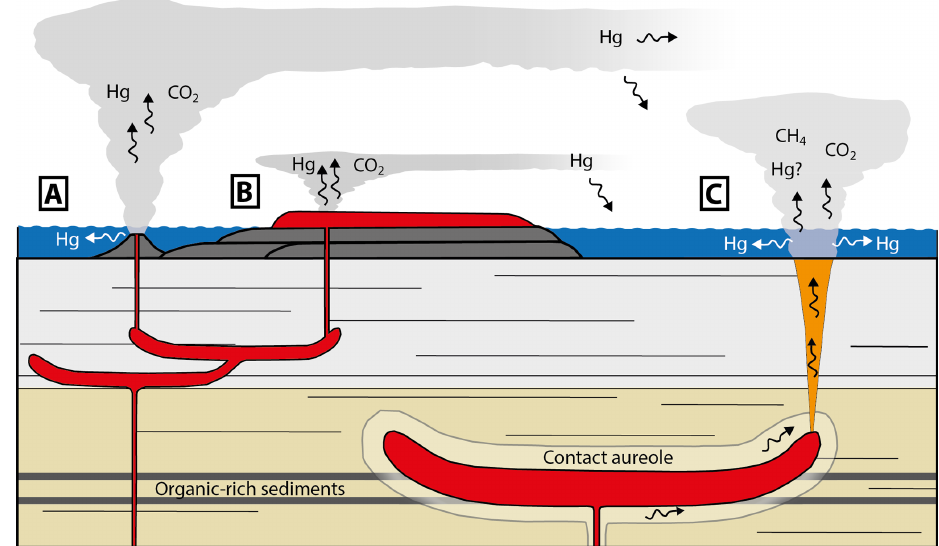
Figure 2. A schematic diagram (not to scale) showing the various emplacement methods of the NAIP and their control on the magnitude and distribution of Hg in the environment. (A) Shallow marine eruptions lead to highly explosive Surtseyan-type volcanism, resulting in wide dispersal of tephra and Hg in the high atmosphere. Some Hg may be transferred to seawater. (B) Effusive flood basalt volcanism releases Hg to the atmosphere, either the troposphere or stratosphere depending on the explosiveness of the eruption. (C) Hydrothermal vent complex explosions from the edges of sill intrusions in organic-rich sedimentary basins. Mercury is likely to be added to the overlying water column, but some Hg may also reach the atmosphere. Adapted from Heimdal et al.